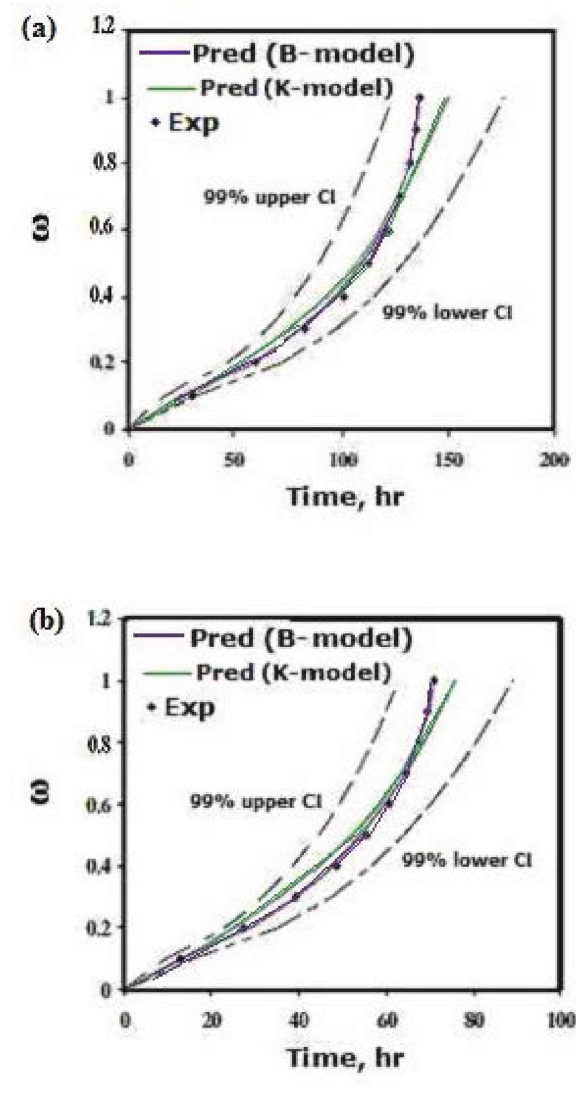
Figure 10: Comparison of the experimental and predicted values of mean time to reach a speci fi ed damage state by CDM (K-model) and B-model approach with relative con fi dence interval (CI) at 870° C/56 MPa: (a) top and (b) bottom portion of service exposed reformer